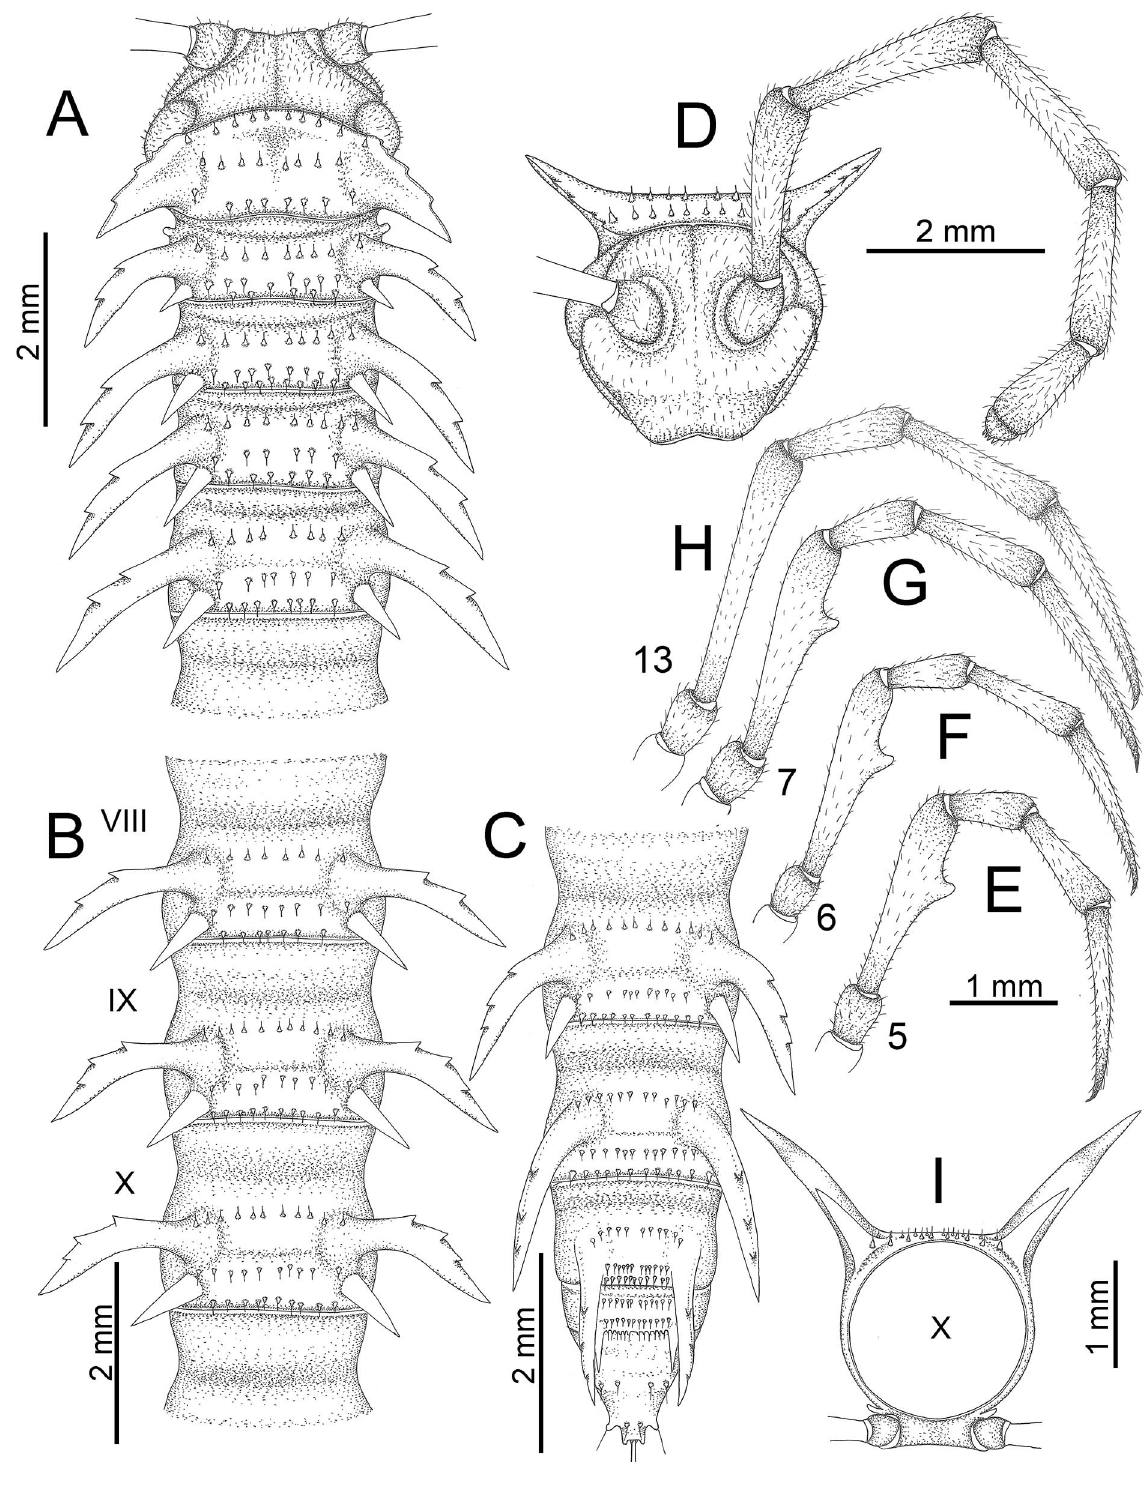
Fig. 20. Gigaxytes suratensis Srisonchai, Enghoff & Panha gen. et sp. nov . , ♂ paratype. A . Anterior body part. B . Body rings 8–10. C . Posteriormost body rings and telson. D . Head and antenna. E . ♂ leg 5 (right). F . ♂ leg 6 (right). G . ♂ leg 7 (right). H . ♂ leg 13 (right). I . Midbody